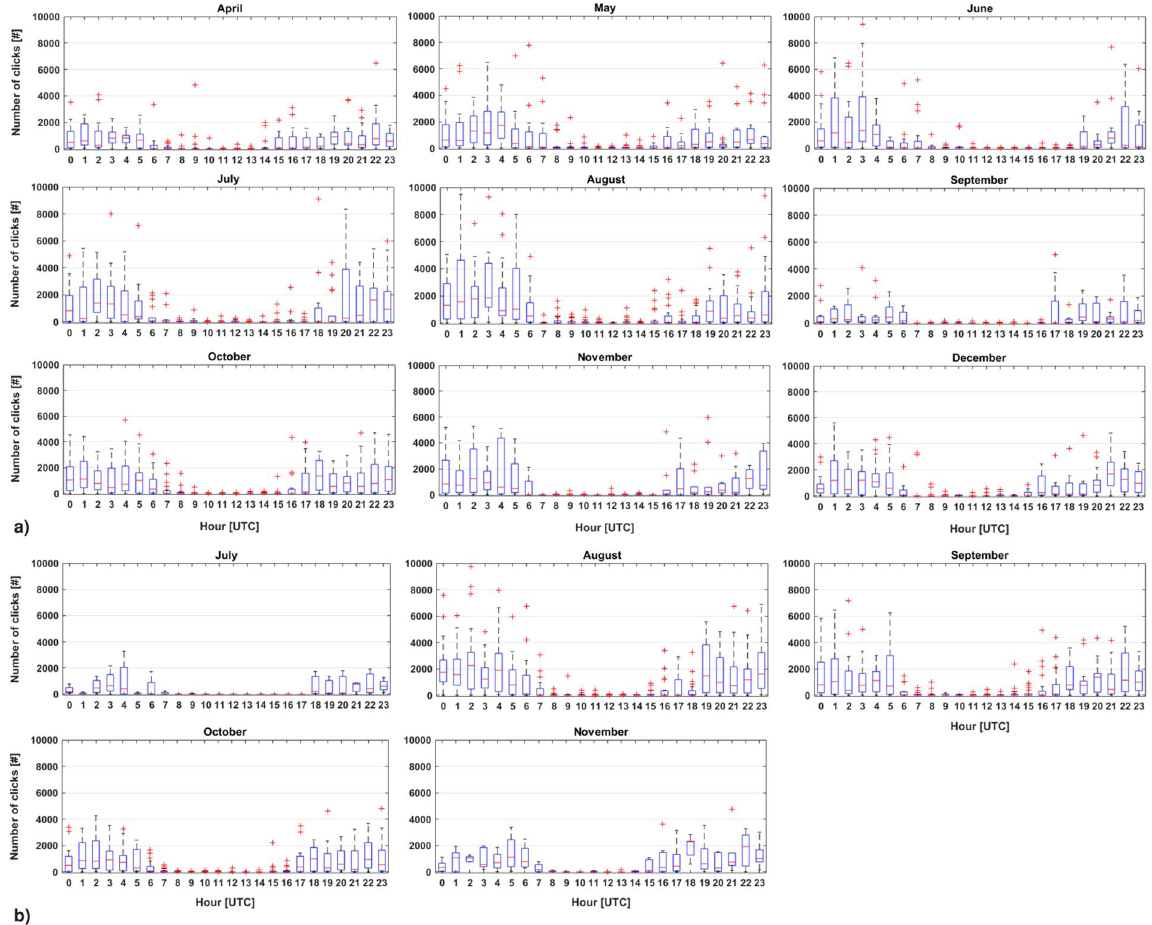
Figure 4. Boxplot of the number of clicks recorded per hour in each month. In each box, the central mark indicates the median, and the bottom and top edges of the box indicate the 25 th and 75 th percentiles, respectively. Whiskers extend to the most extreme data points not considered outliers, and outliers are plotted individually using the ‘ + ’ symbol (in red). ( a ) Data acquired in 2005; ( b ) Data acquired in